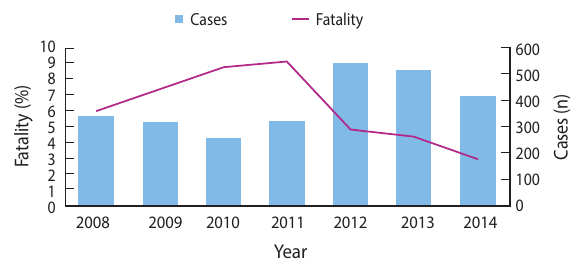
Figure 1. Distribution of voluntary poisoning cases (n=2,690) by pesticides according to years and specific lethality (p<0.001).